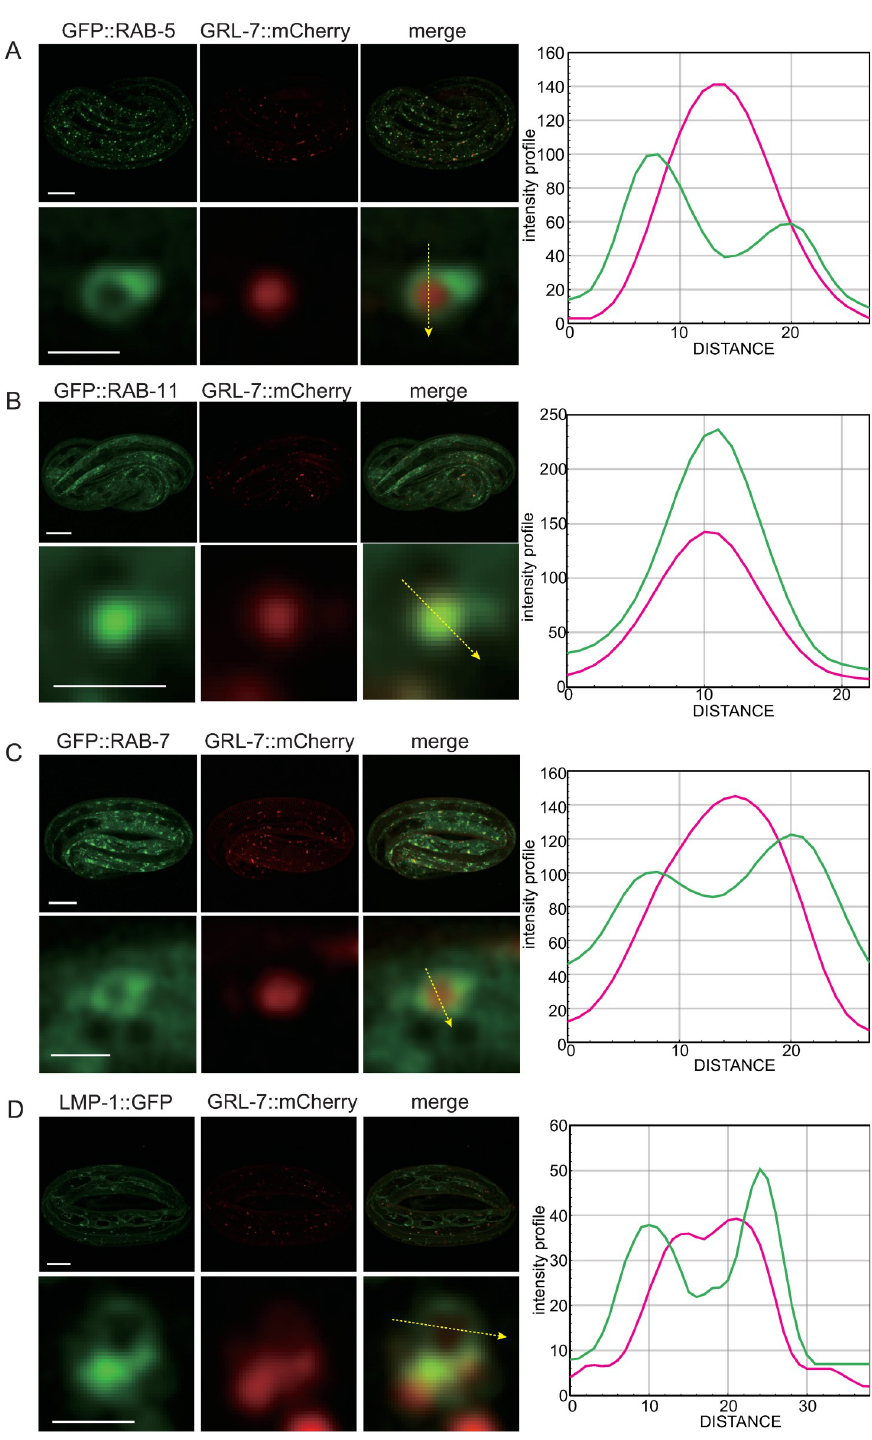
Fig 5. GRL-7::mCherry are localized to endosomes and lysosomes. Super-resolution images showing the expression patterns of GRL-7::mCherry and markers for endosomes and lysosomes. (A–D) Images on top rows show the maximum intensity Z projection of an entire embryo expressing indicated reporters, and scale bars indicate 10 μ m. Images on bottom rows show a magnified view of a Z section selected from the Z stacks of the above row, and scale bars indicate 1 μ m. Intensity profiles along the arrow in each of the magnified image are shown on the right.